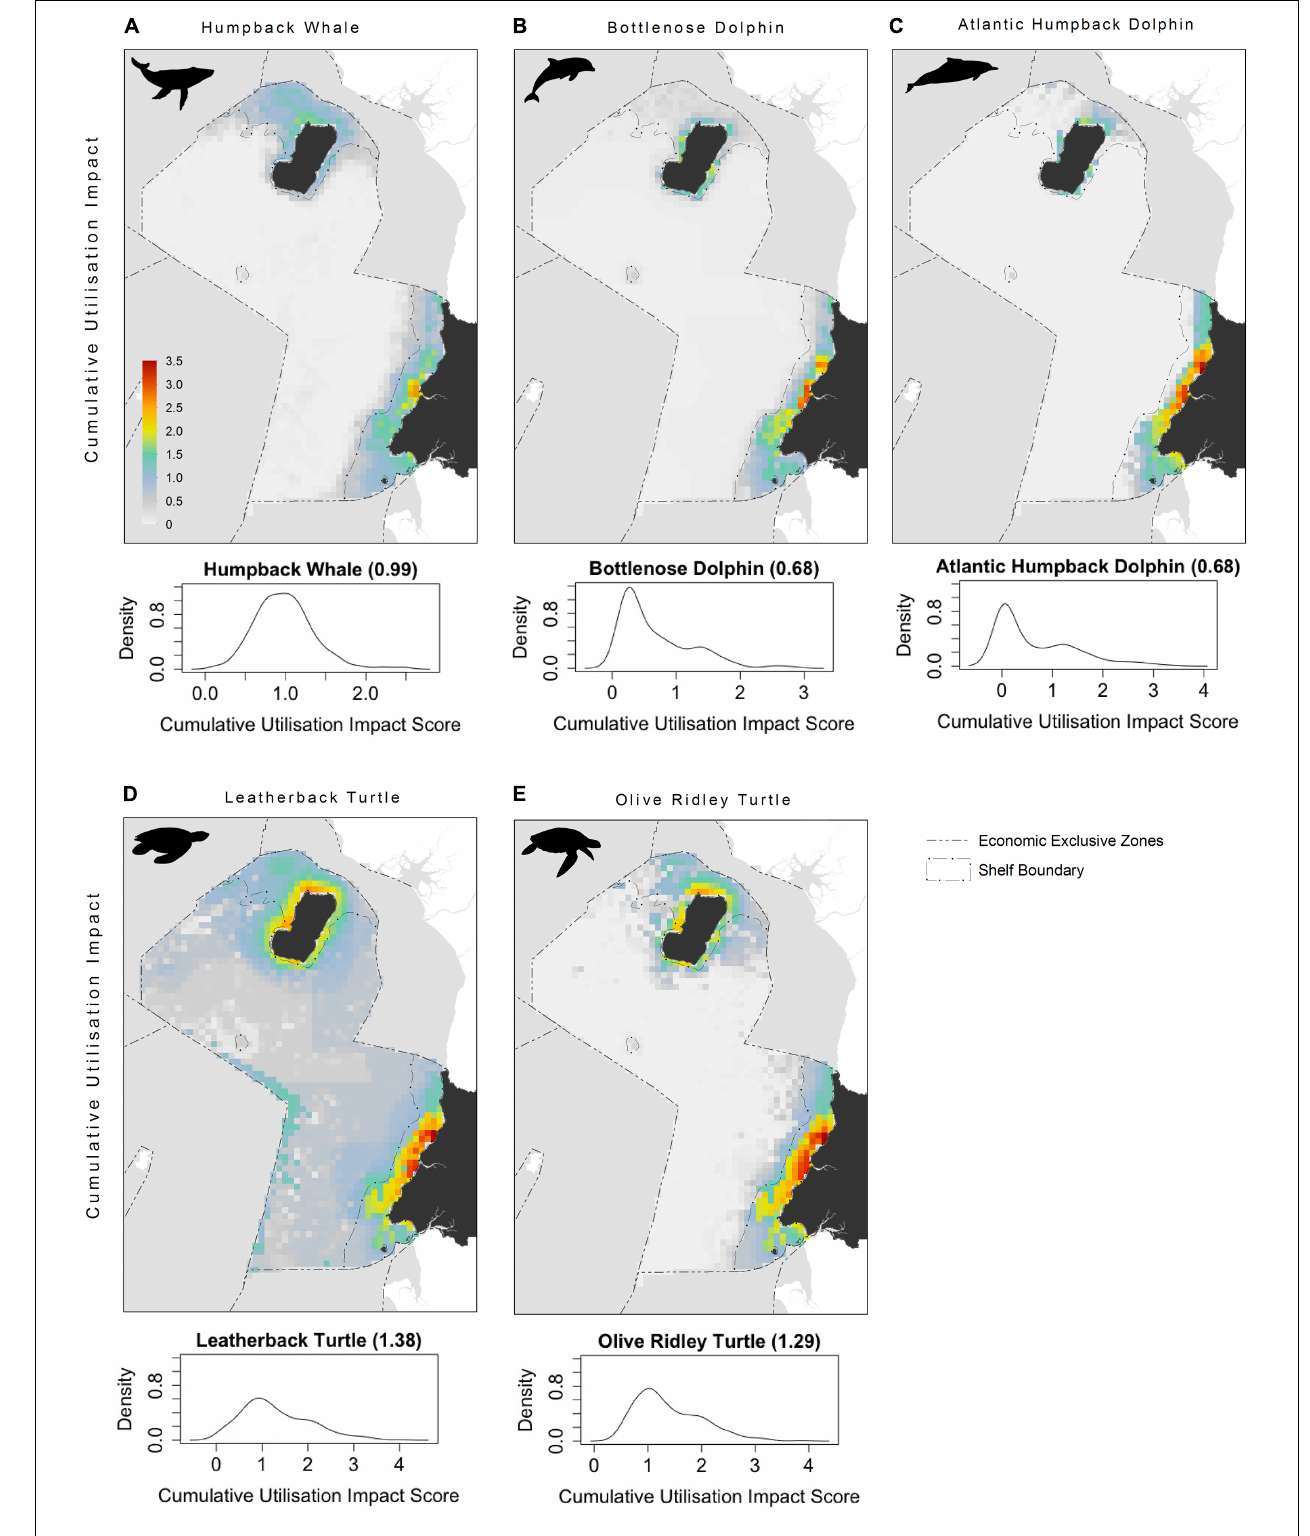
FIGURE 4 | Cumulative utilization impact distributions for: (A) Humpback whale; (B) Bottlenose dolphin; (C) Atlantic humpback dolphin; (D) leatherback turtle; and (E) olive ridley turtle. Density plots of per-pixel cumulative utilization score calculated for each species representing CUI scores (continental shelf scores only). See Figure 1 for additional geographical information for the Bioko-Corisco-Continental area of Equatorial Guinea’s exclusive economic zone.